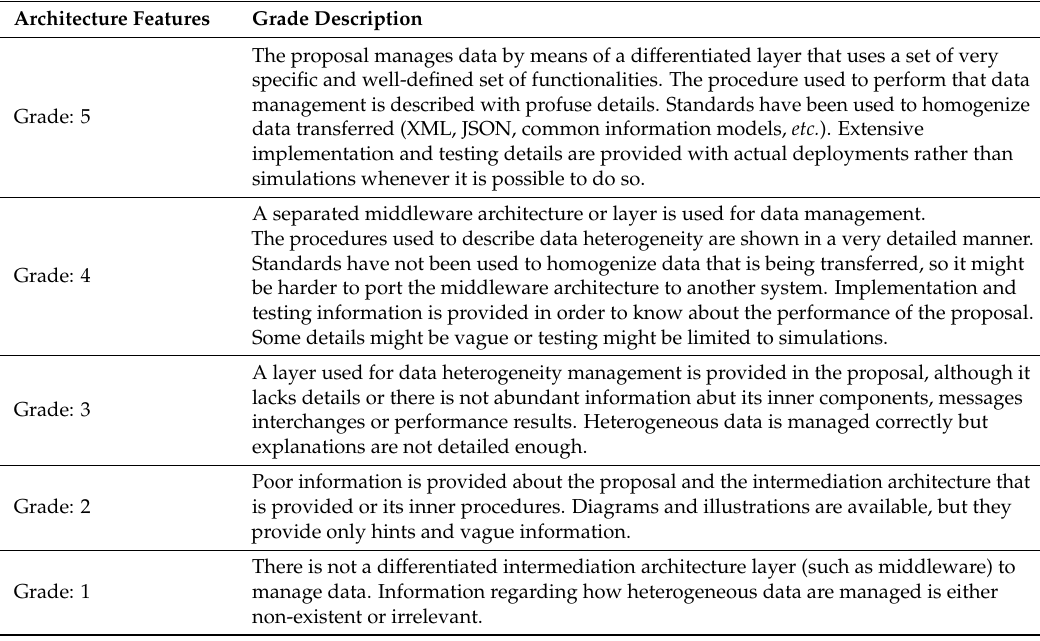
Table 1. Data heterogeneity management assessment.